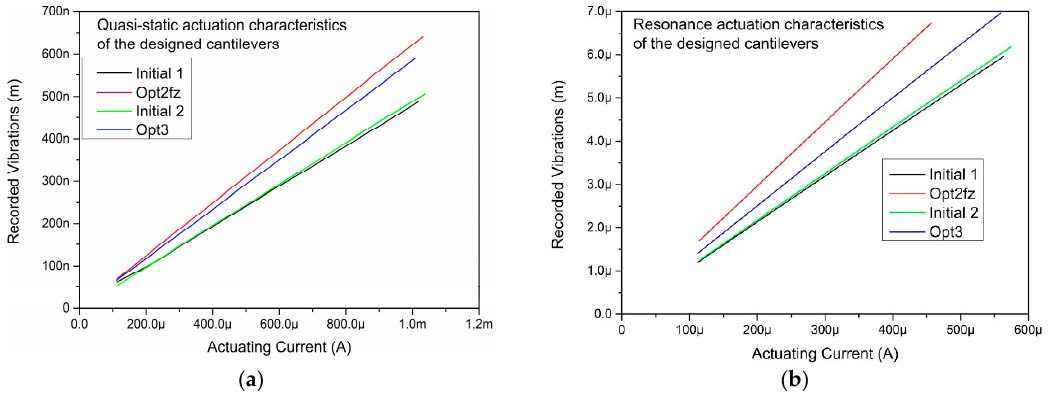
Figure 6. Results of the electromagnetic actuation of the optimal cantilevers ( a ) results recorded in the